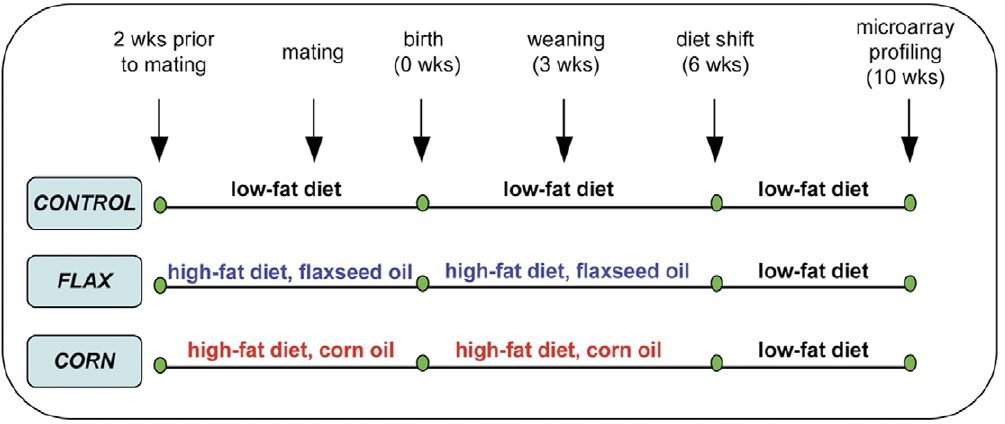
Figure 1. Schematic overview of experimental study design. Wild-type FVB mice were exposed from two weeks prior to conception to 6 weeks of age to a low-fat (5%) regular mouse diet, or to high-fat (24%) diets based on either corn oil or flaxseed oil. At 6 weeks of age, all mice were shifted to the regular low-fat diet until terminal sacrifice at 10 weeks of age.